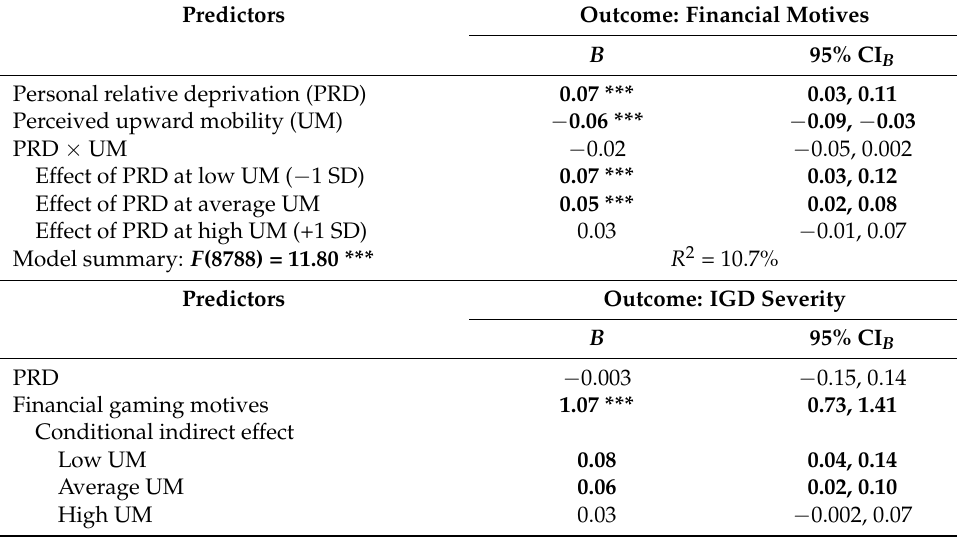
Table 4. Moderated mediation summary for Study 1.